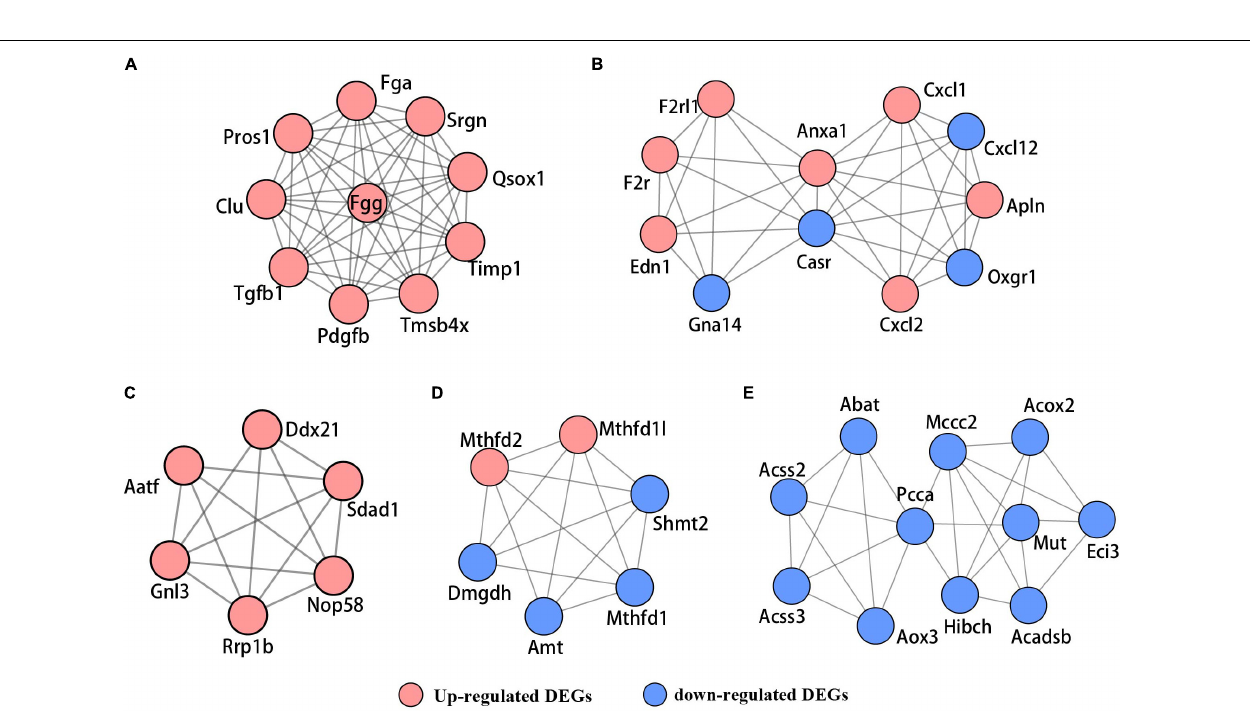
Frontiers in Genetics |